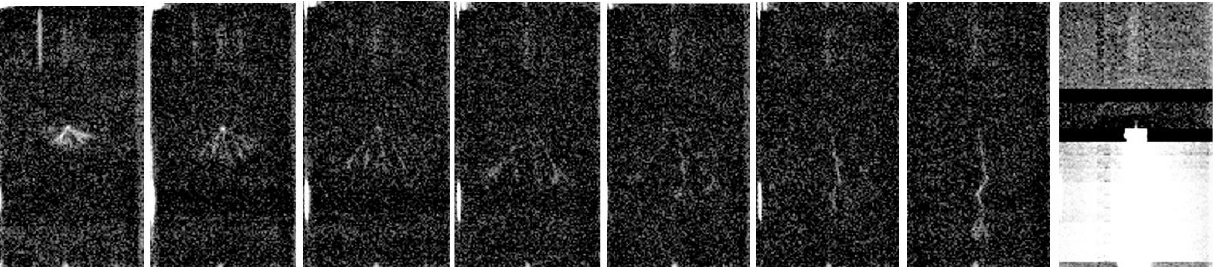
Figure A2. 1% DEA in cyclohexane, positive polarity, 227 kV. 4.16 µs between frames, Time-To- Breakdown (TTB) ≈ 40 µs.